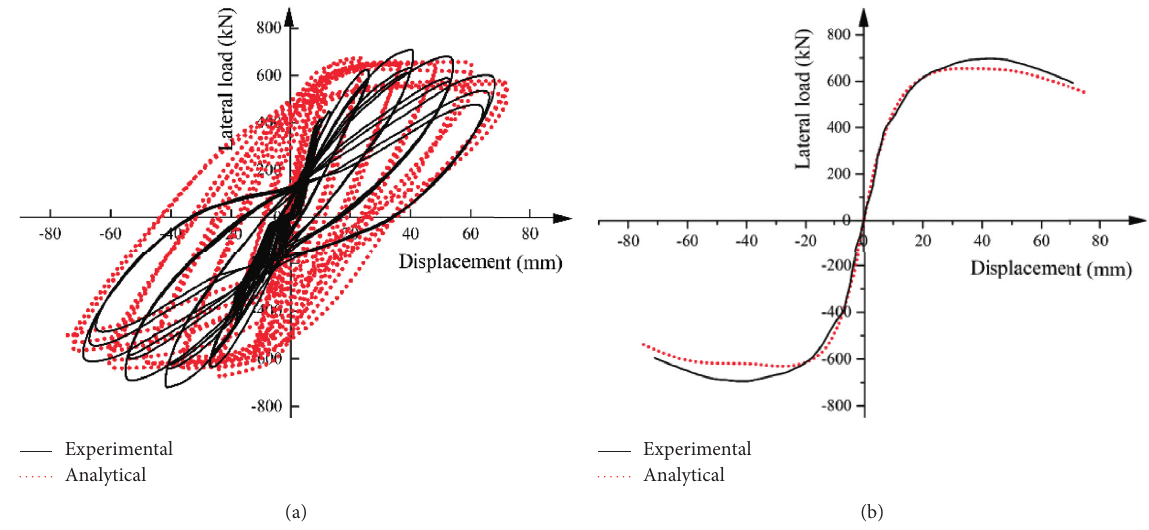
Figure 13: Comparison of simulated and experimental load-displacement curves: (a) hysteresis curves; (b) skeleton